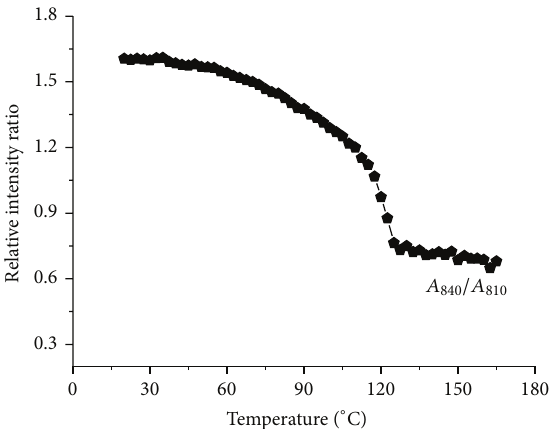
Figure 10: Intensity ratio ( 𝐴 840 /𝐴 810 ) of regularity bands versus temperatures.